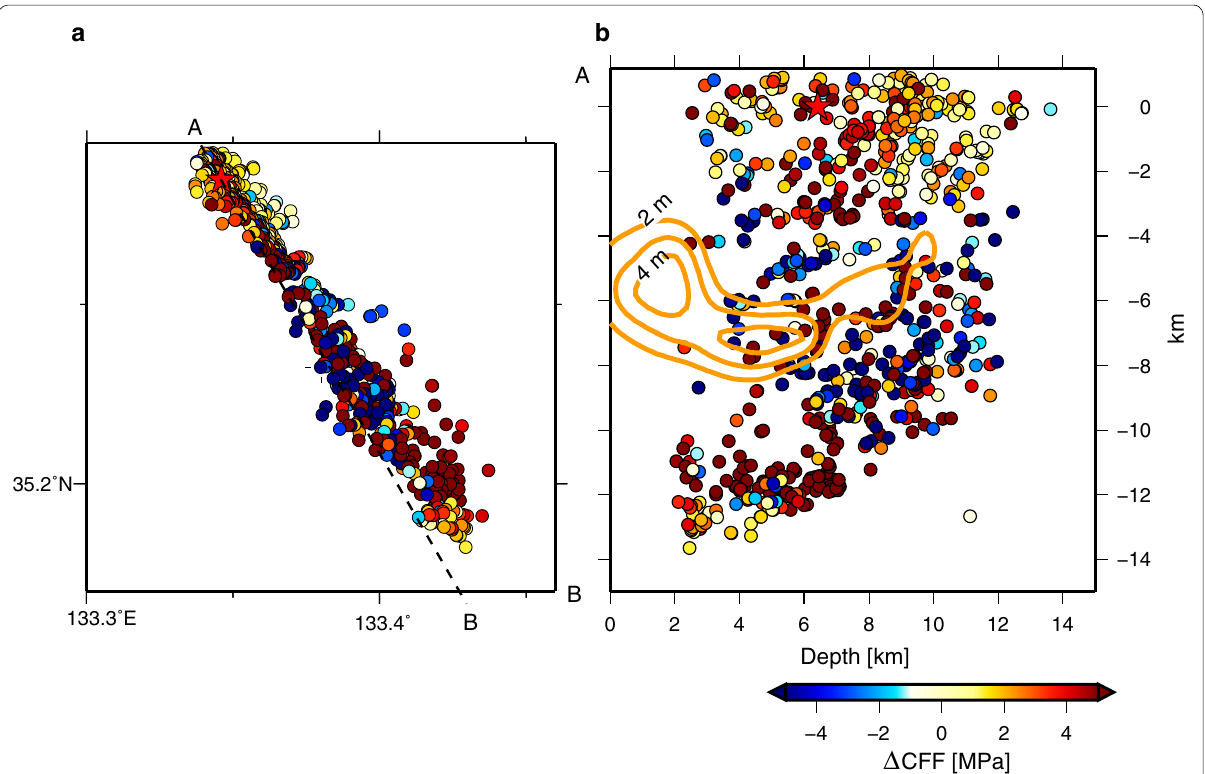
Fig. 10 Spatial distribution of ΔCFF for the aftershock focal mechanisms around Faults 1 and 2. a Epicentral distribution and b depth section on line A–B. The orange contours projected on ( b ) indicate areas of large slip exceeding a dislocation of 2.0 m as estimated by Iwata and Sekiguchi (2002). The red star indicates the starting point of mainshock